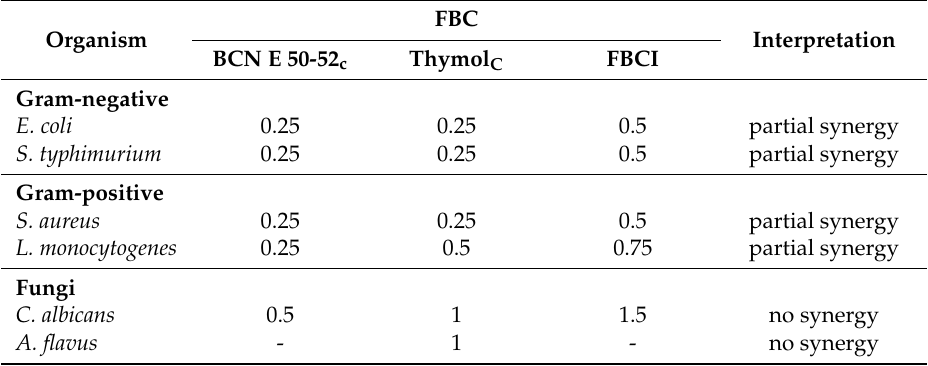
Table 4. The fractional bactericidal concentration index (FBCI) of synergism